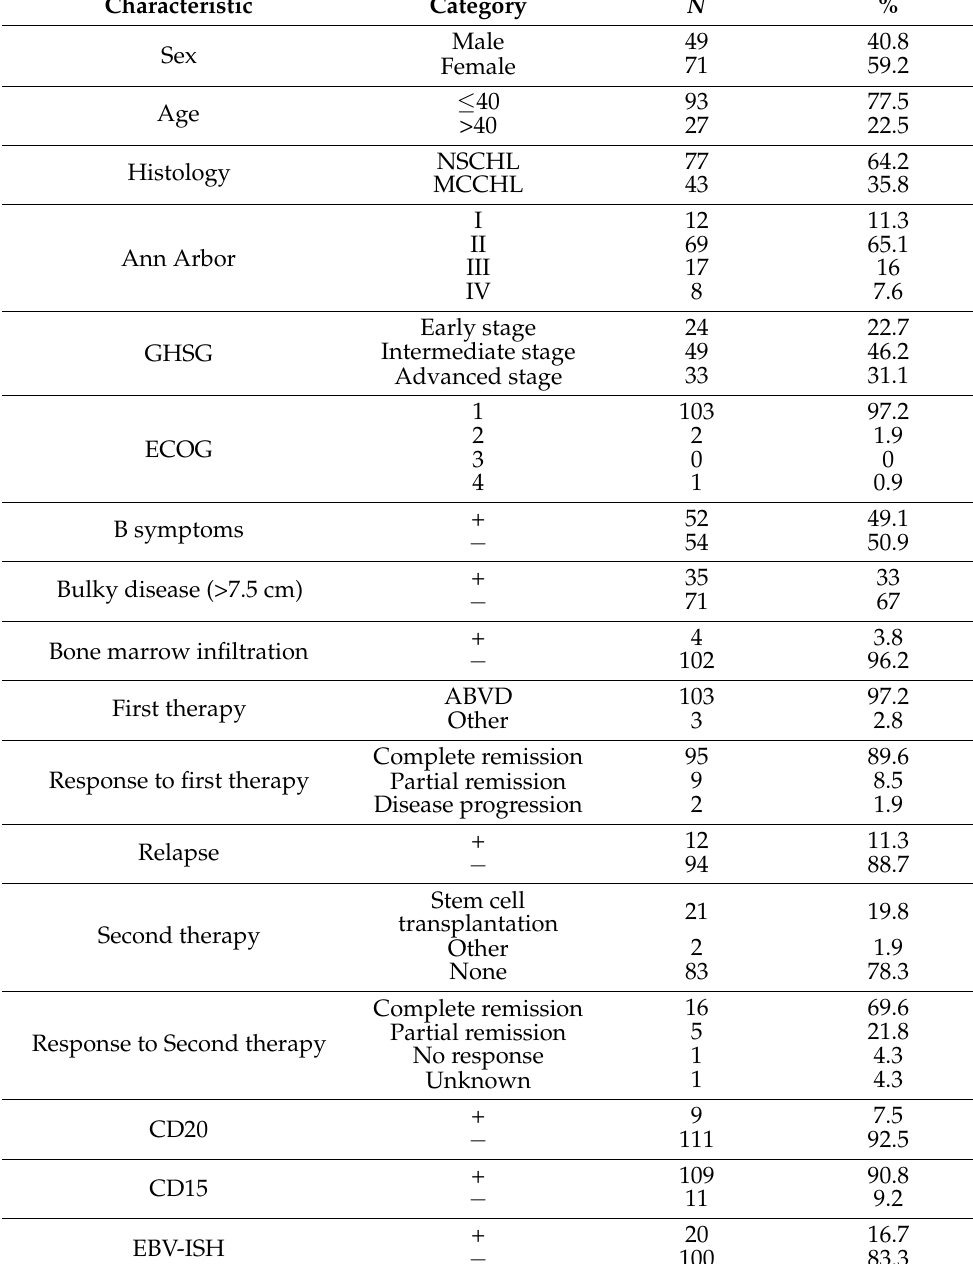
Table 2. Clinical data of the